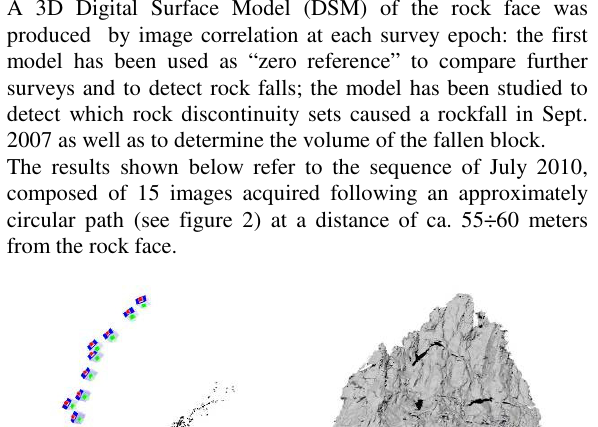
Figure 1. The Marbrees peak in Mont Blanc massif: an image of the sequence.